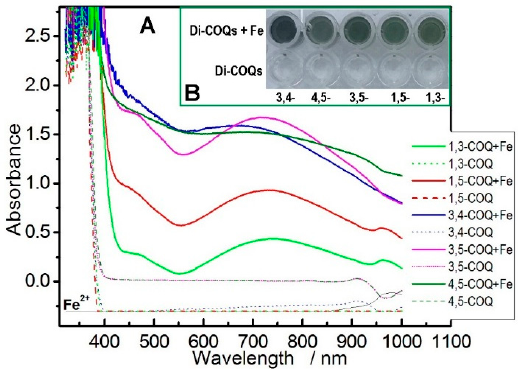
Figure 2. ( A ) UV-Vis spectra of the five di-COQs and their chelating products with excess Fe 2+ . ( B ) The colors of complexes, resulting from the product mixtures, were taken by a camera.